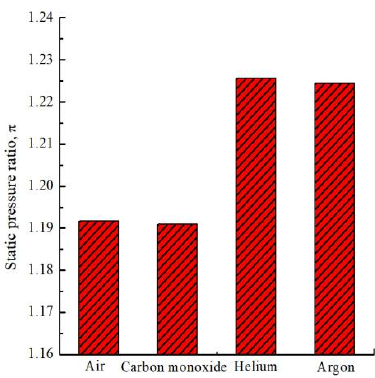
Figure 5. Static pressure ratio using dissimilar fluids.